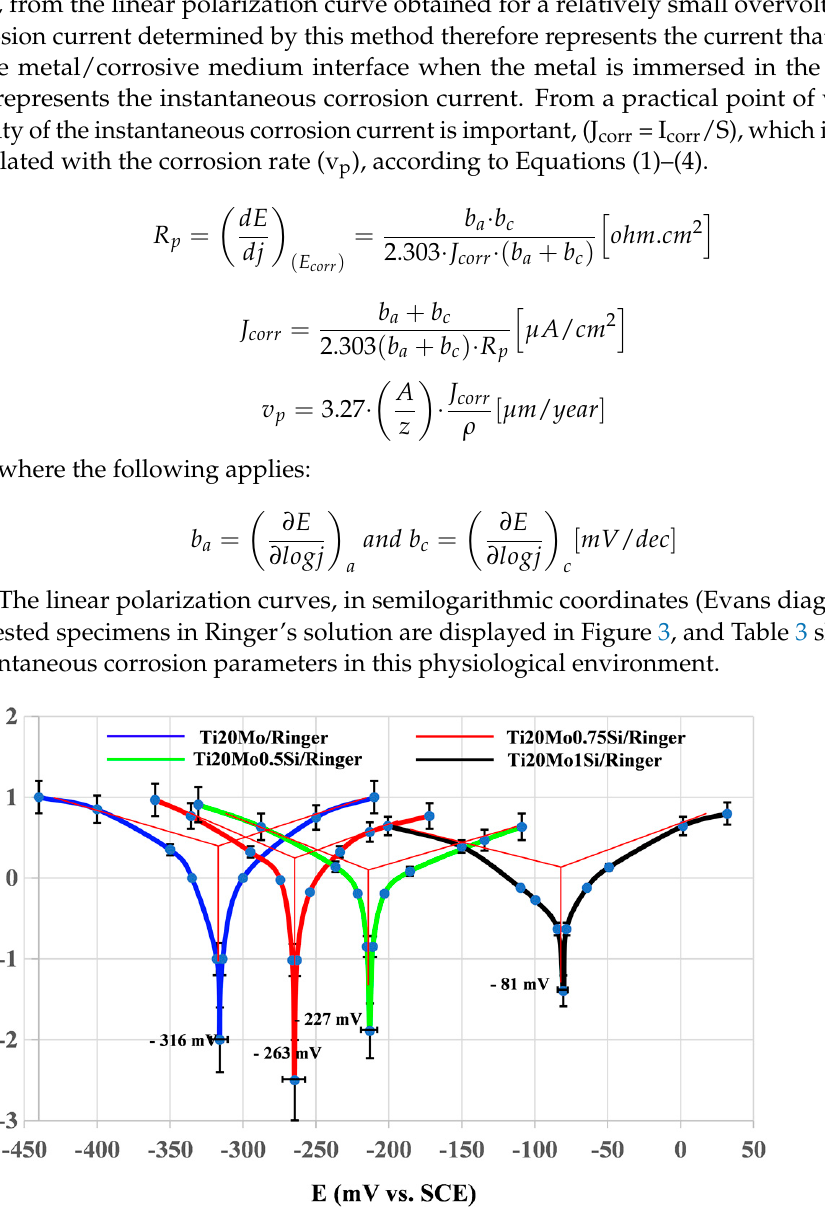
Figure 3. Linear polarization curves in semi-logarithmic coordinates for Ti–Mo–Si alloys in Ringer’s